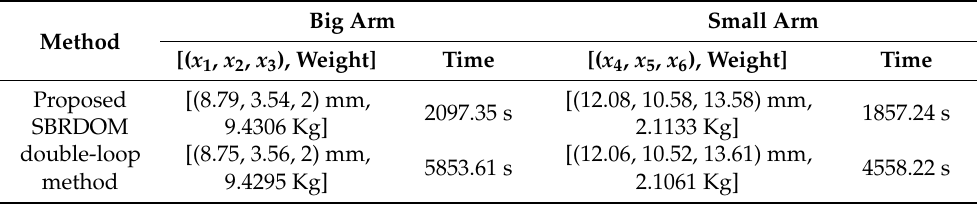
Table 7. Comparison of different reliability design optimization